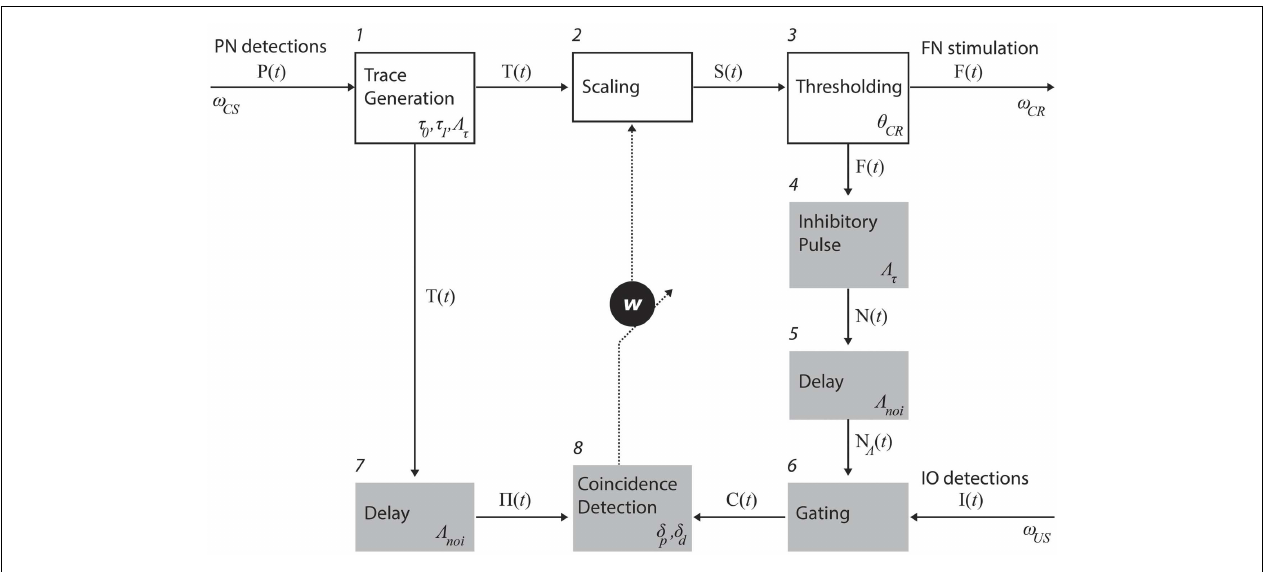
FIGURE 3 | Functional model of the cerebellum. The processes in the top row (white boxes) map PN activity into action; in the case of eye-blink conditioning, tone detections into eye-blinks. Such mapping is controlled by the memory parameter w .The shaded processes adapt the mapping, namely,